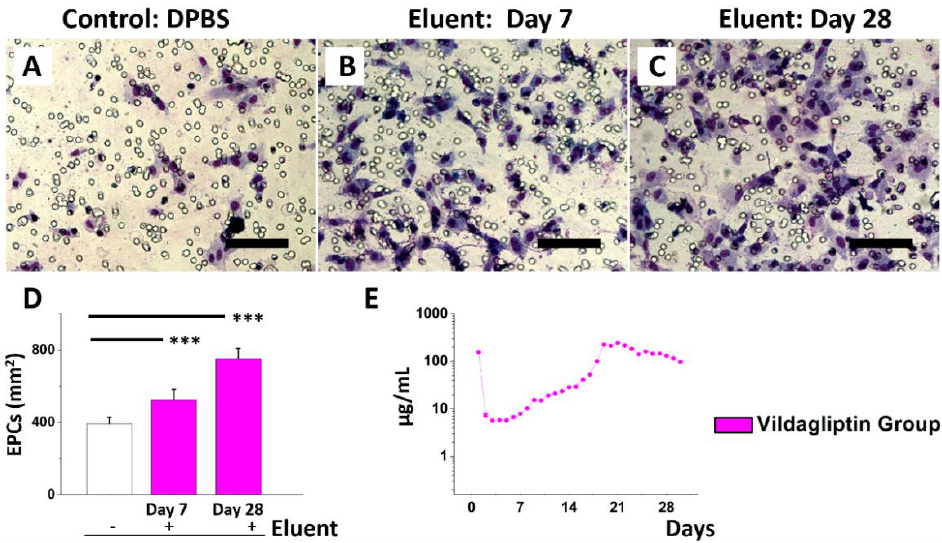
Figure 4. Eluent of vildagliptin/PLGA membranes for EPCs migration test. EPCs added with DPBS only ( A ), day 7 eluent ( B ), or day 28 eluent ( C ). Eluents with vildagliptin increase EPCs’ migration ( E ). In vitro release of vildagliptin ( D ) (*** p < 0.01).